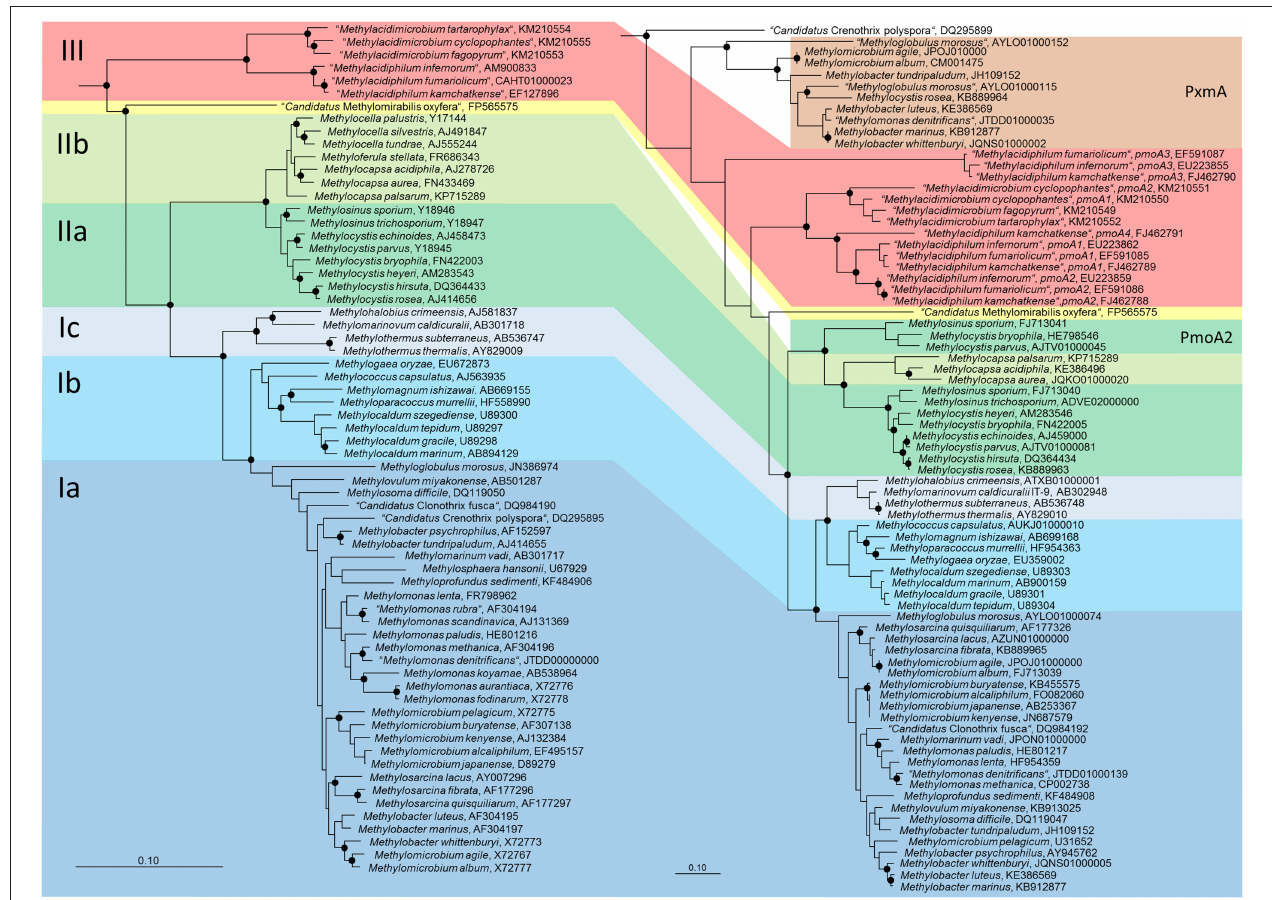
FIGURE 1 | Phylogenetic trees showing the phylogeny of methanotrophic type strains based on 16S rRNA gene sequences (left tree) and PmoA sequences (right tree). The neighbor joining trees were calculated using the ARB software package (Ludwig et al., 2004) based on 1556 nucleotide positions with Jukes Cantor correction or 160 amino acid positions with Kimura correction, respectively. PmoA sequences of Methylobacter luteus, Methylobacter whittenburyi , and Methylomicrobium pelagicum are not available from the type strains, but were taken from a different strain representing the species. The 16S rRNA gene based tree was rooted with sequences of methanogenic Archaea (AB301476, M60880, AB065296, AM114193, AB196288), the PmoA tree with AmoA sequences of ammonia-oxidizing bacteria (NC_004757, X90822). Dots label branch points that were confirmed in maximum likelihood trees. The scale bars display 0.10 changes per nucleotide or amino acid